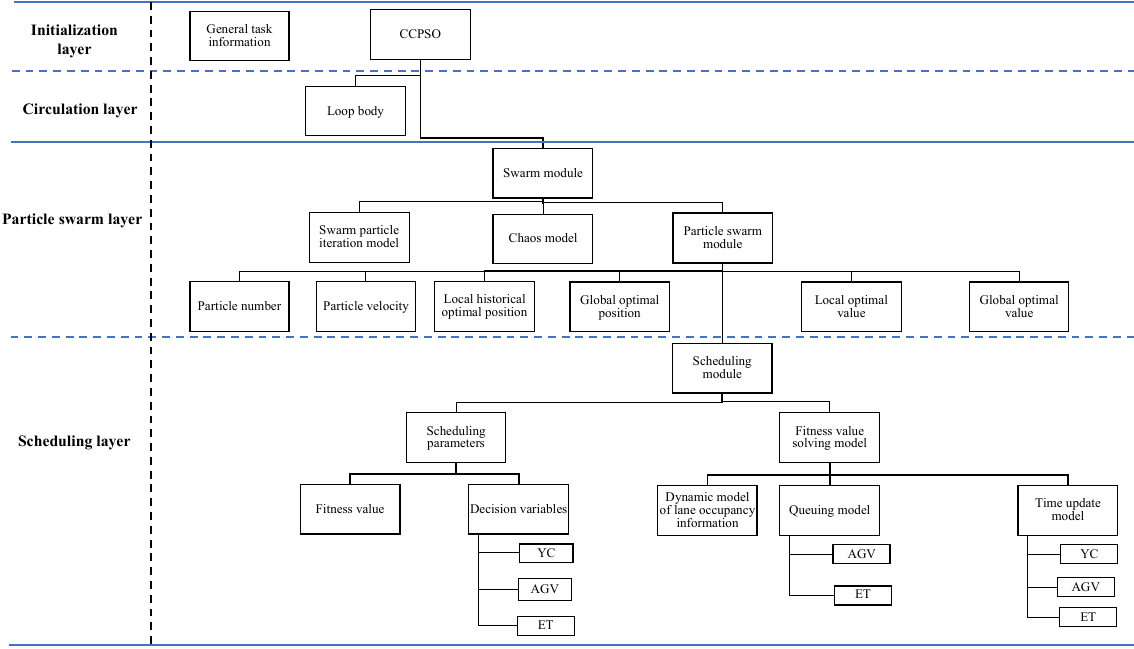
Figure 4. Layered Figure 4. Layered architecture.